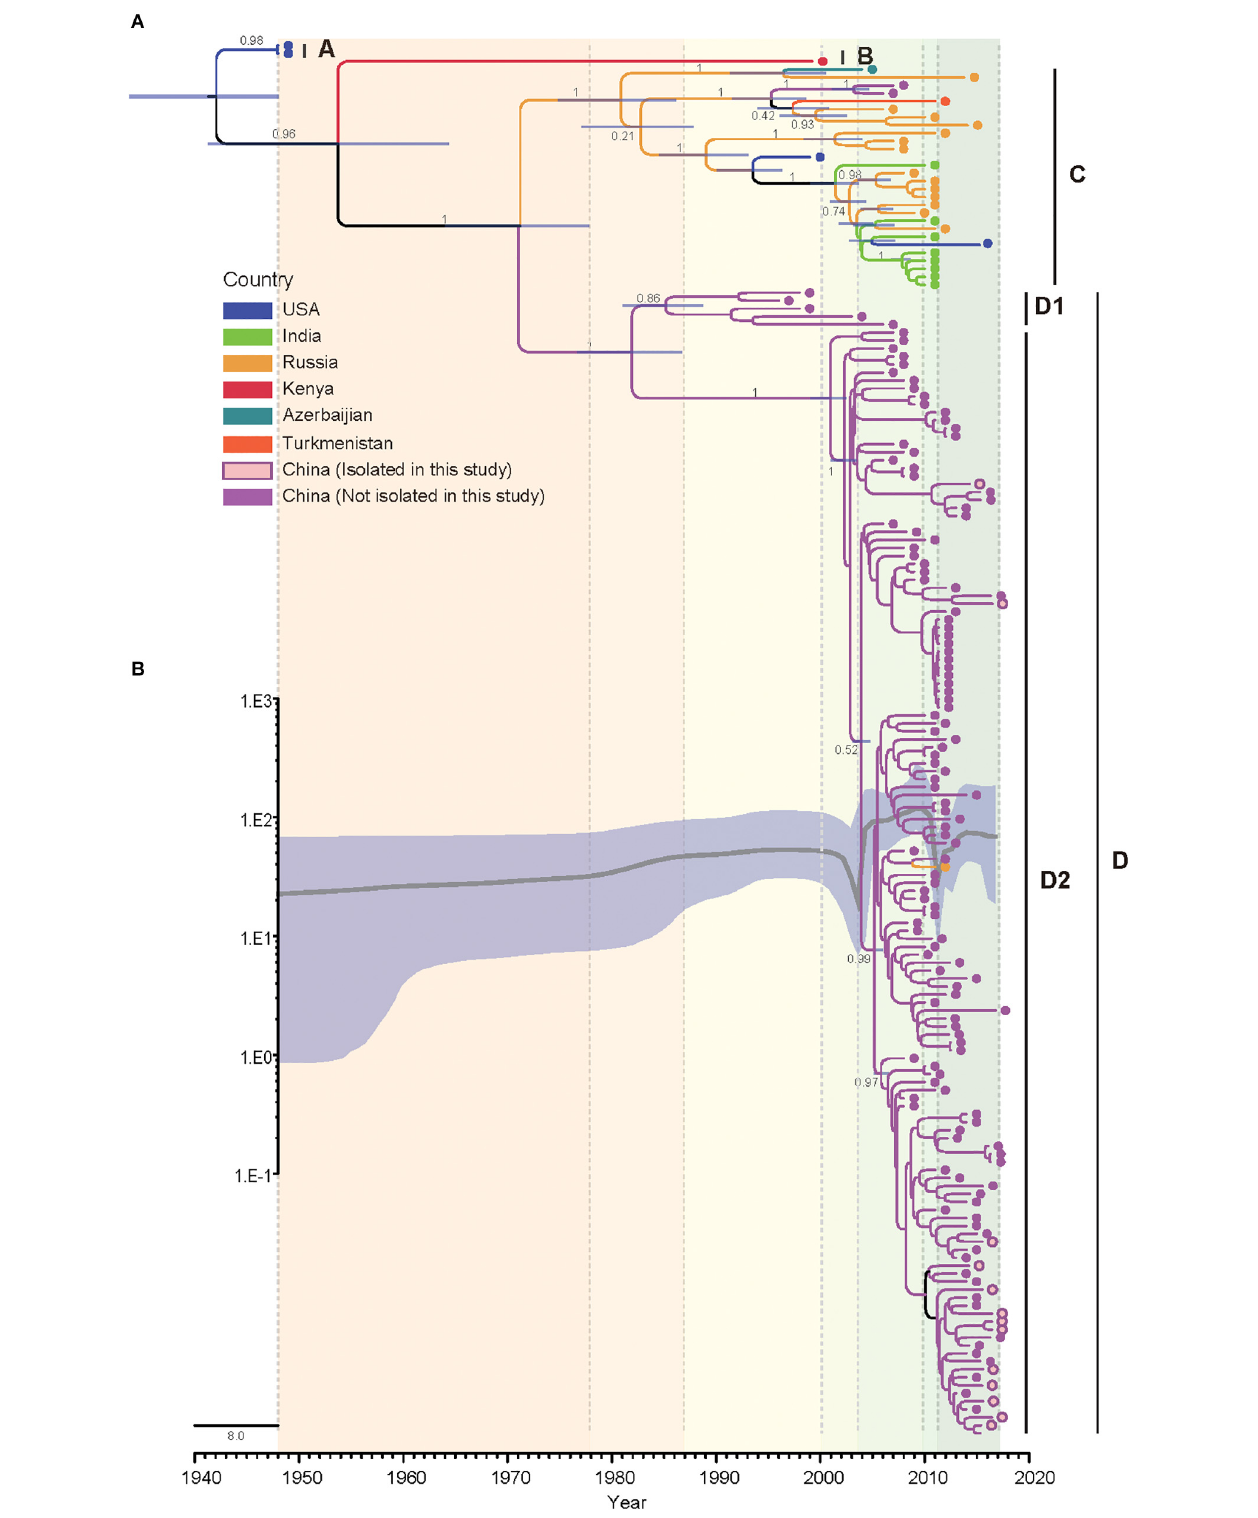
FIGURE 3 | Bayesian phylogenetic analysis and demographic reconstruction of the CVA4 VP1 gene sequences (915 nts). (A) Bayesian phylogeny was conducted by BEAST with a Bayesian skyline tree prior and a relaxed molecular clock model. (B) The x -axis is the time scale (years) and the y -axis is the effective population size in logarithmic Ne τ scale. The thick solid line indicates the median estimates and the shaded area indicates the 95% highest posterior density.